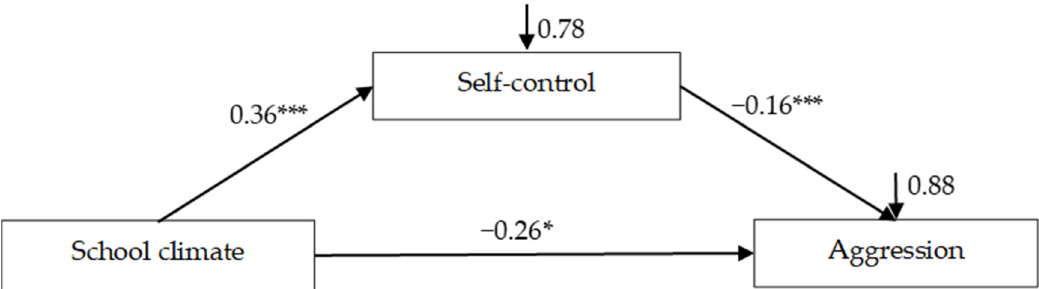
Figure 2. Model of the mediating role of self-control between school climate and aggression. Values are standardized coefficients. * p < 0.05 ， *** p < 0.001.